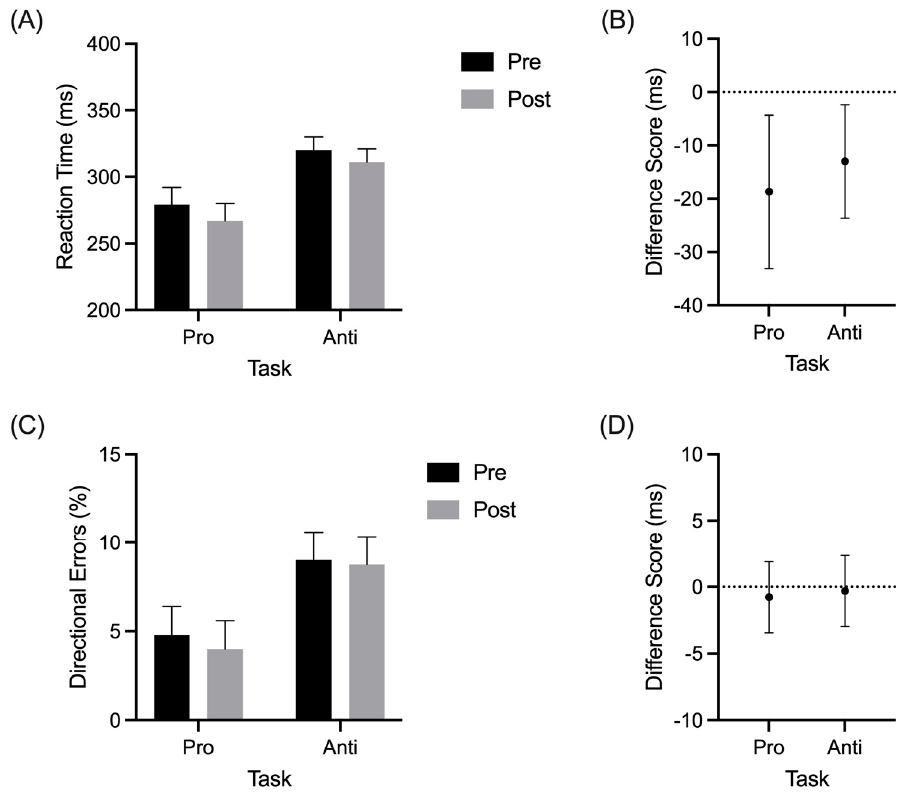
Figure 2. Group mean reaction time (RT) ( A ) and directional errors ( C ) for pro- and antisaccades at pre- and postexercise assessments. The offset panels show an RT ( B ) and directional error ( D ) difference scores (postexercise minus pre-exercise) with error bars representing 95% between-participant confidence intervals ( B ). An absence of overlap between the error bars and zero (i.e., horizontal dashed line) indicates a reliable difference inclusive to a test of the null hypothesis.